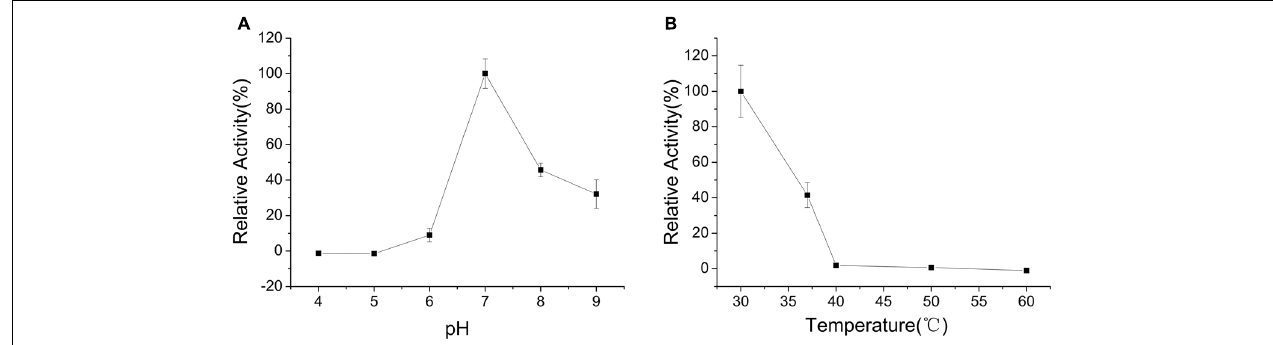
FIGURE 4 | Effects of pH and temperature on the stability of CHAO YT − 02 . (A) Effect of pH on the stability of recombinant CHAO YT − 02 . The residual activity was determined at 50 ◦ C. The value at 50 ◦ C is 100%. (B) Effect of temperature on the stability of recombinant CHAO YT − 02 . The residual activity was determined at pH 7.0 (phosphate buffer, 50 mM) and 50 ◦ C. The value at pH 7.0 is 100%.